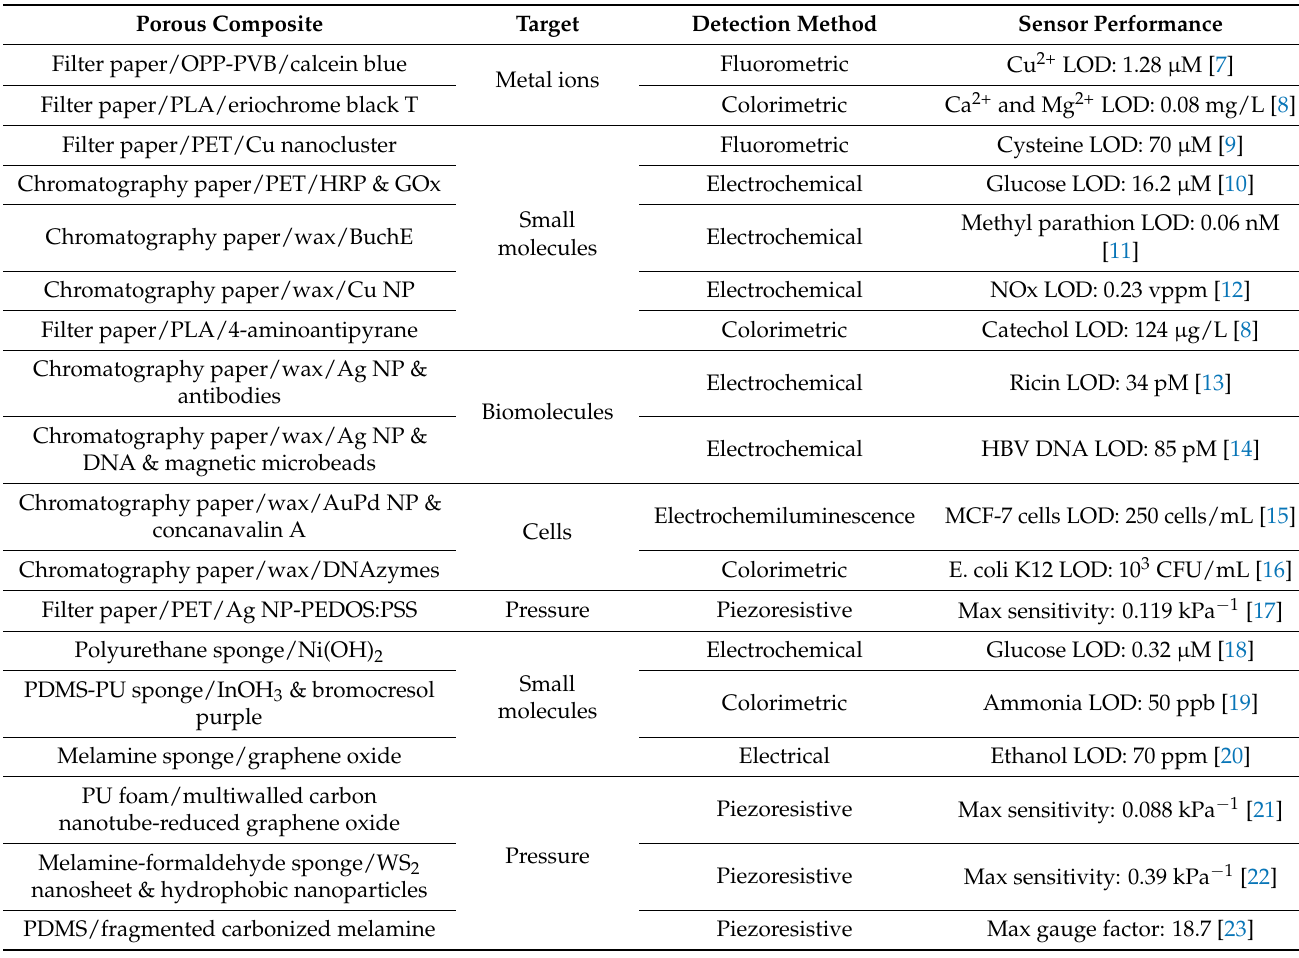
Table 1. Representative examples of sensing devices that utilize porous composite materials. Porous Composite